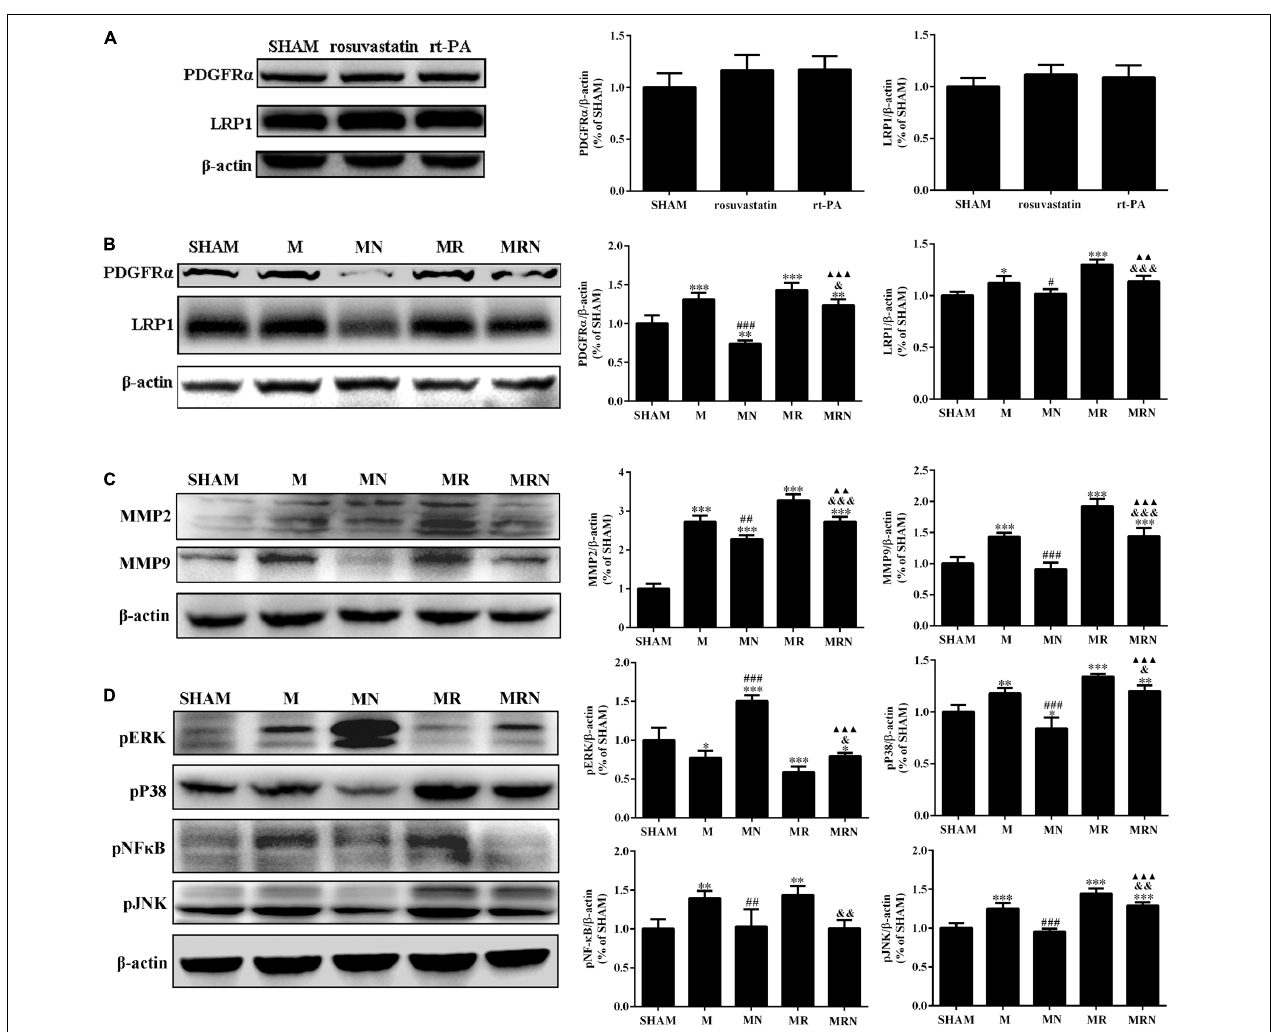
FIGURE 6 | The rosuvastatin-mediated reduction in BBB damage induced by rt-PA reperfusion after MCAO was associated with MAPK pathways. (A) The bands for the PDGFR- α , LRP-1, and β -actin proteins in the SHAM, 1 mg/kg rosuvastatin-alone treatment (rosuvastatin), and rt-PA-alone treatment (rt-PA) groups determined by Western blotting. The relative densities were assessed by calculating the ratios of the PDGFR- α and LRP-1 proteins to β -actin and comparing the differences with the SHAM group, P > 0.05. Means ± SEM, n = 3. (B) The bands for the PDGFR- α , LRP-1, and β -actin proteins in the SHAM group, mice that underwent MCAO for 3 h followed by reperfusion for 24 h (M), mice receiving a high dose of rosuvastatin prior to MCAO for 3 h followed by reperfusion for 24 h (MN), mice that underwent MCAO for 3 h followed by rt-PA reperfusion for 24 h (MR), and mice pretreated with a high dose of rosuvastatin prior to MCAO for 3 h followed by rt-PA reperfusion for 24 h (MRN) were determined by Western blotting. The relative densities were assessed by calculating the ratios of the PDGFR- α and LRP-1 proteins to β -actin and comparing the differences with the SHAM group ( ∗ P < 0.05, ∗∗ P < 0.01, ∗∗∗ P < 0.001), the M group ( # P < 0.05, ### P < 0.001), the MR group ( & P < 0.05, &&& P < 0.001), and the MN group ( (cid:78)(cid:78) P < 0.01, (cid:78)(cid:78)(cid:78) P < 0.001). Means ± SEM, n = 3. (C) The bands for the MMP2, MMP9, and β -actin proteins were detected by Western blotting of samples from the SHAM, M, MN, MR, and MRN groups. The relative densities were assessed by calculating the ratios of the MMP2 and MMP9 proteins to β -actin and comparing the differences with the SHAM group ( ∗∗∗ P < 0.001), the M group ( ## P < 0.01, ### P < 0.001), the MR group ( &&& P < 0.001), and the MN group ( (cid:78)(cid:78) P < 0.01 and (cid:78)(cid:78)(cid:78) P < 0.001). Means ± SEM, n = 3. (D) The bands for the pERK, pP38, pJNK, pNF κ B, and β -actin proteins were detected by Western blotting samples from the SHAM, M, MN, MR, and MRN groups. The relative densities were assessed by calculating the ratios of pERK, pP38, pJNK, and pNF κ B proteins to β -actin and comparing the differences with the SHAM group ( ∗ P < 0.05, ∗∗ P < 0.01, ∗∗∗ P < 0.001), the M group ( ## P < 0.01, ### P < 0.001), the MR group ( & P < 0.05, && P < 0.01), and the MN group ( (cid:78)(cid:78)(cid:78) P < 0.001). Means ± SEM, n =